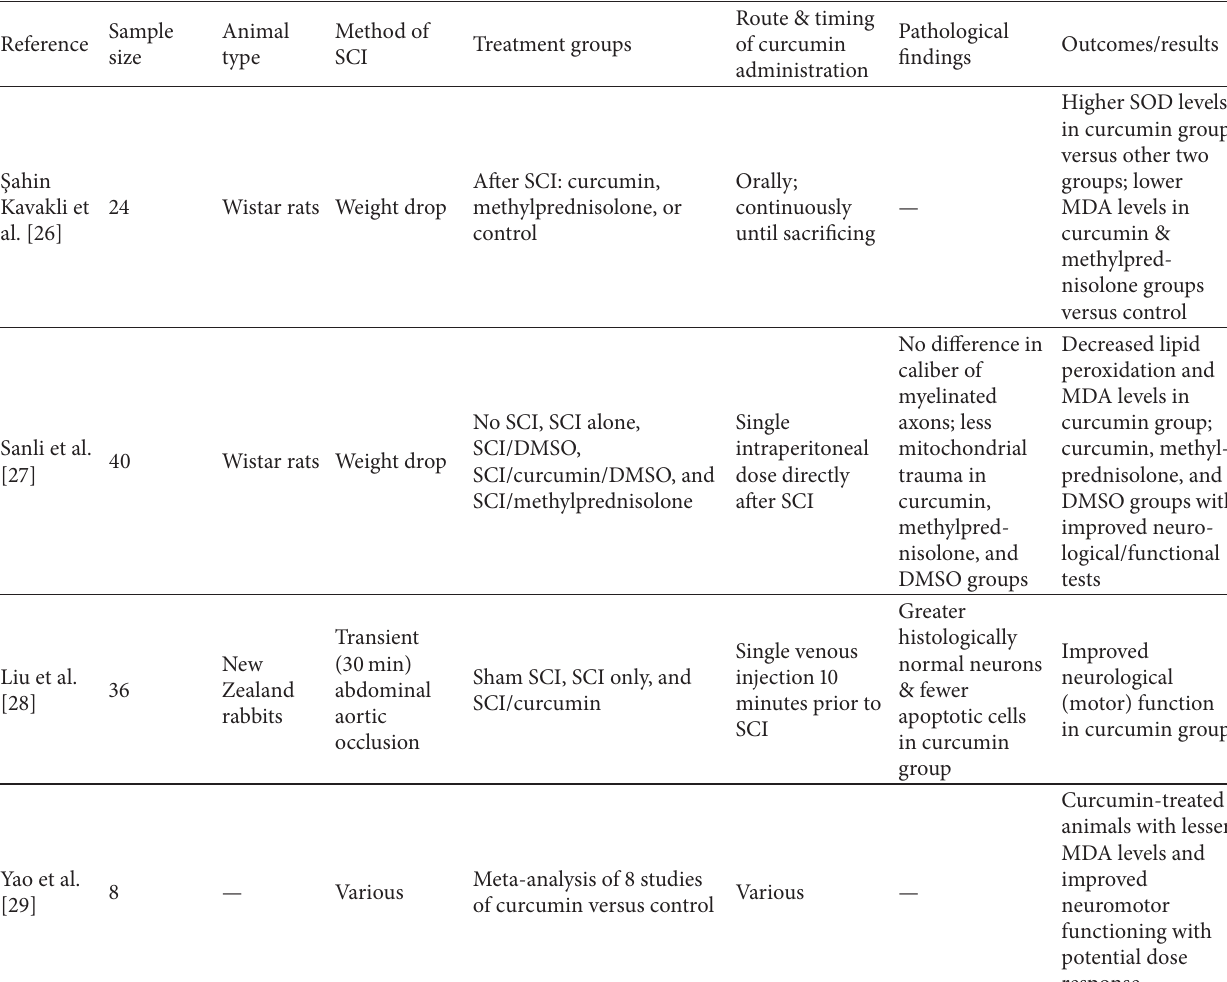
Table 2: Publications examining the antioxidant properties of curcumin. Groups equally divided unless otherwise indicated. SCI, spinal cord injury; SOD, superoxide dismutase (antioxidant); MDA, malondialdehyde (oxidant); DMSO, dimethyl